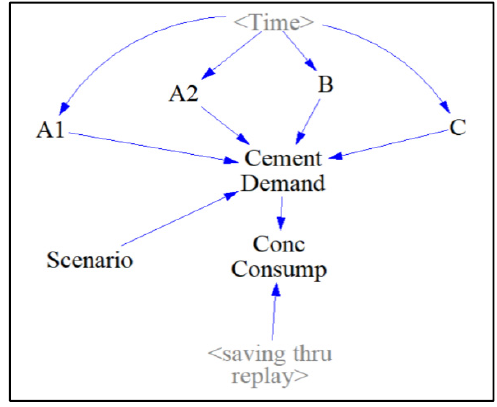
Figure 6. Forecast sector. Figure 6. Forecast